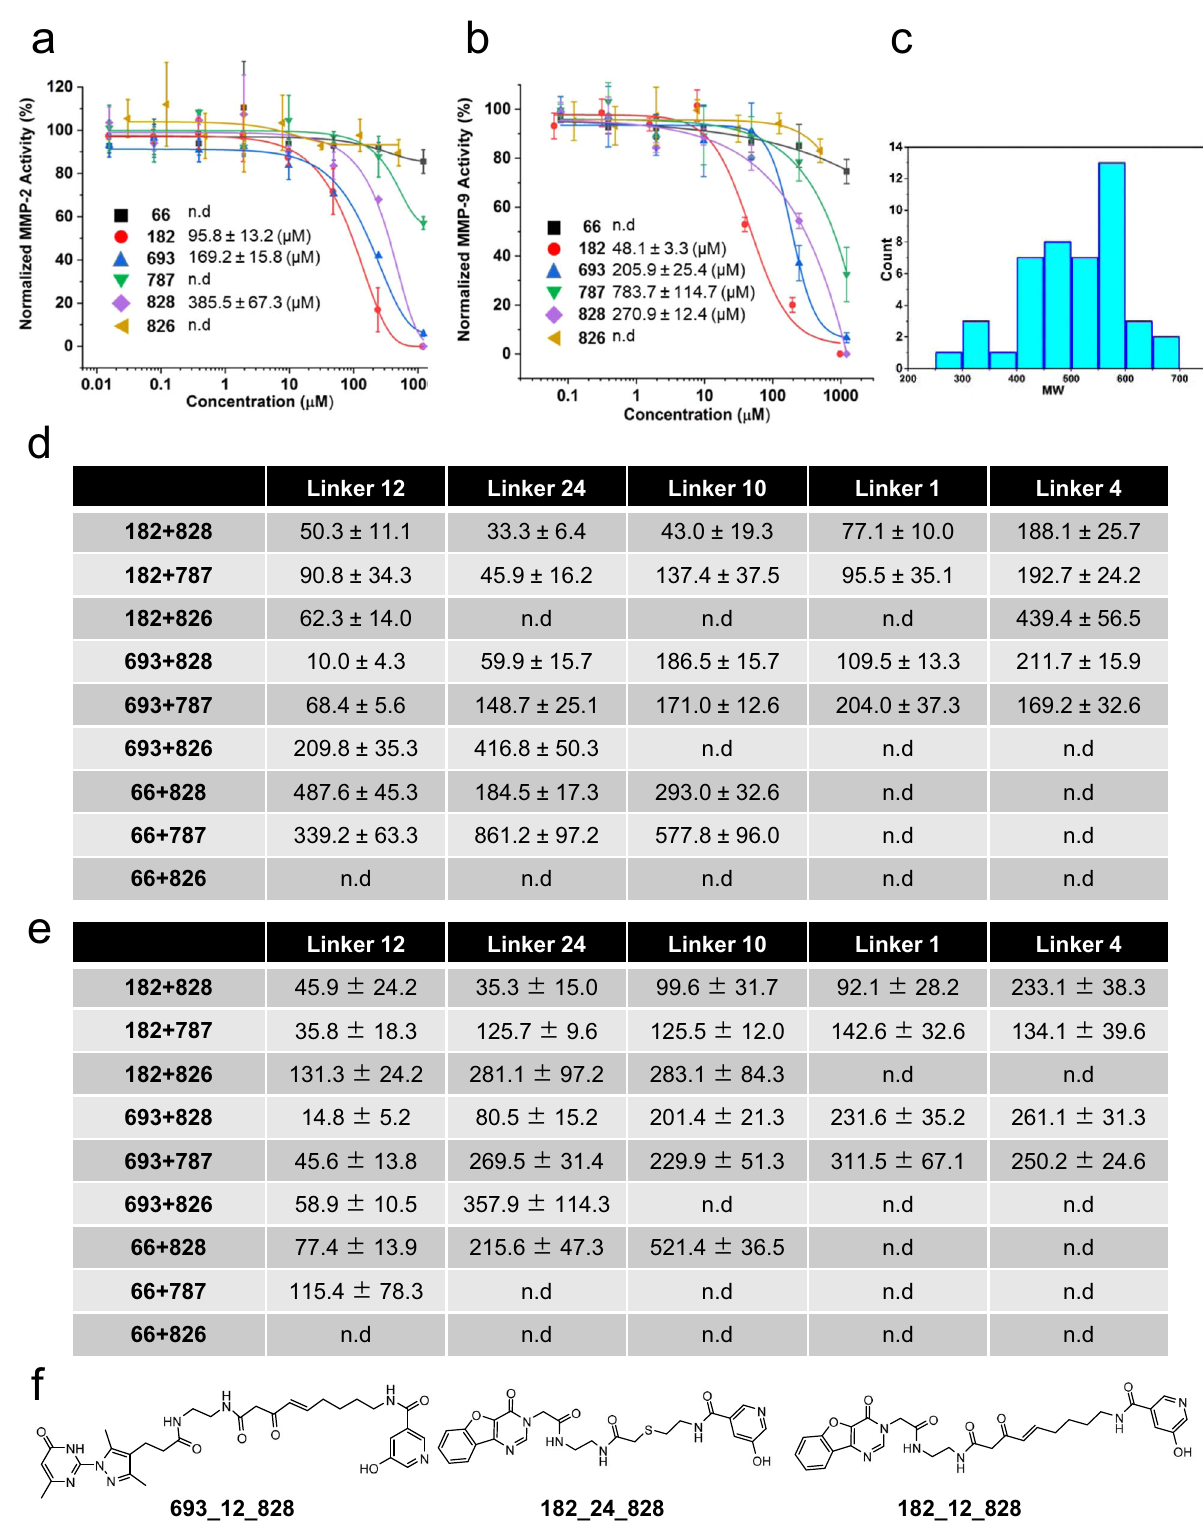
Fig. 5 | Hit resynthesis and validation. a , b Fragments enriched from SL-A ( 66 , 182 , and 693 ) and SL-C ( 787 , 828 , and 826 ) were independently validated by enzyme inhibition assay against MMP-2 and MMP-9. Data are presented as mean values±SD from three independent measurements ( n =3 three biological repli- cates). c Histogram of MW distribution of the 45 re-synthesized small molecule compounds. d , e IC 50 values calculated from dose-response measurements (Sup- plementary Figs. 15, 16, and 17) against MMP-2 and MMP-9 of all compounds. The